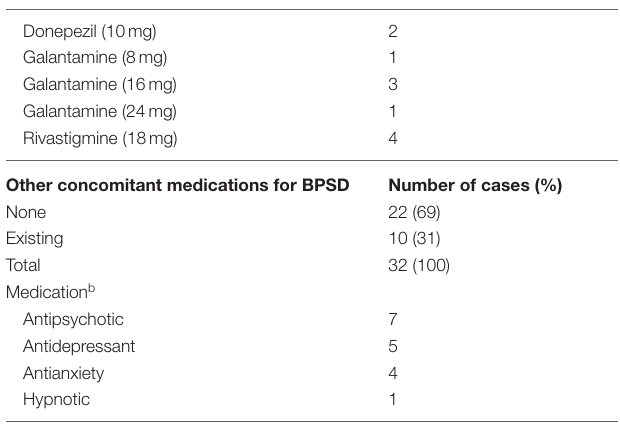
a Missing data = 19. b There are duplicate cases.